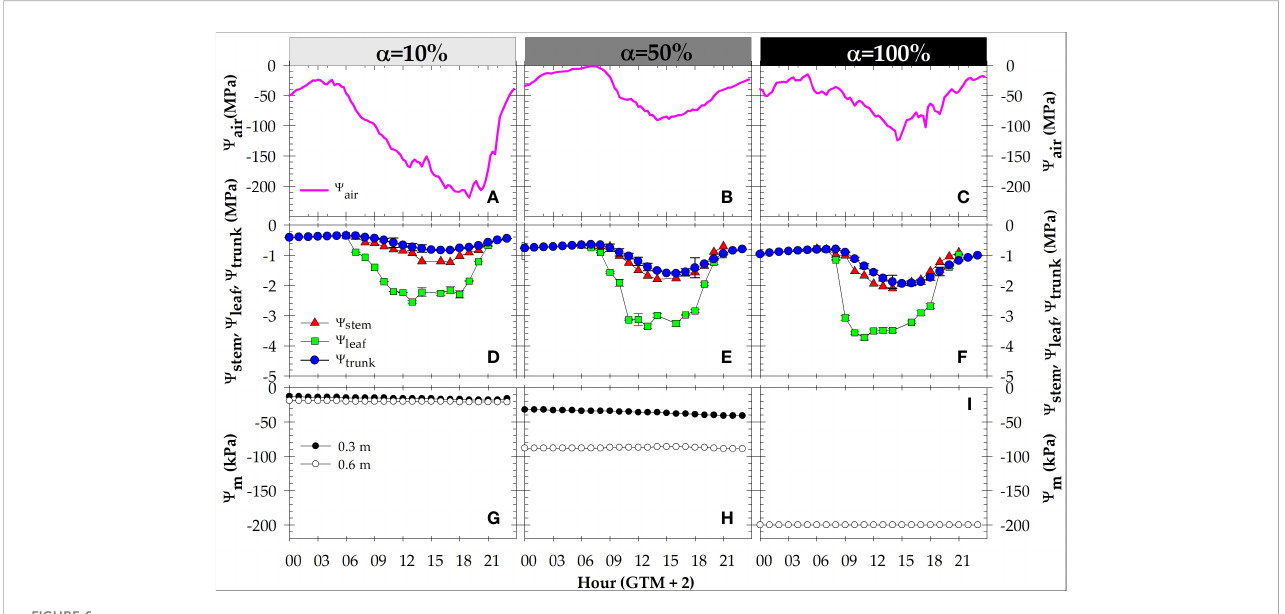
FIGURE 6 Daily time-courses of: (A-C) air water potential ( Y air ); (D-F) leaf ( Y leaf ), stem ( Y stem ), and trunk ( Y trunk ) water potentials; and (G-I) soil matric potential ( Y m ) at 0.3 and 0.6 m in the soil pro fi le, during different irrigation criteria: a =10% (DOY 174), a =50% (DOY 210) and a =100% (DOY 244). Each point is the mean of four leaves, two MTs, and two granular matrix sensors. Vertical bars in the data points are ± SE (not shown when smaller than the symbols). GMT: Greenwich mean